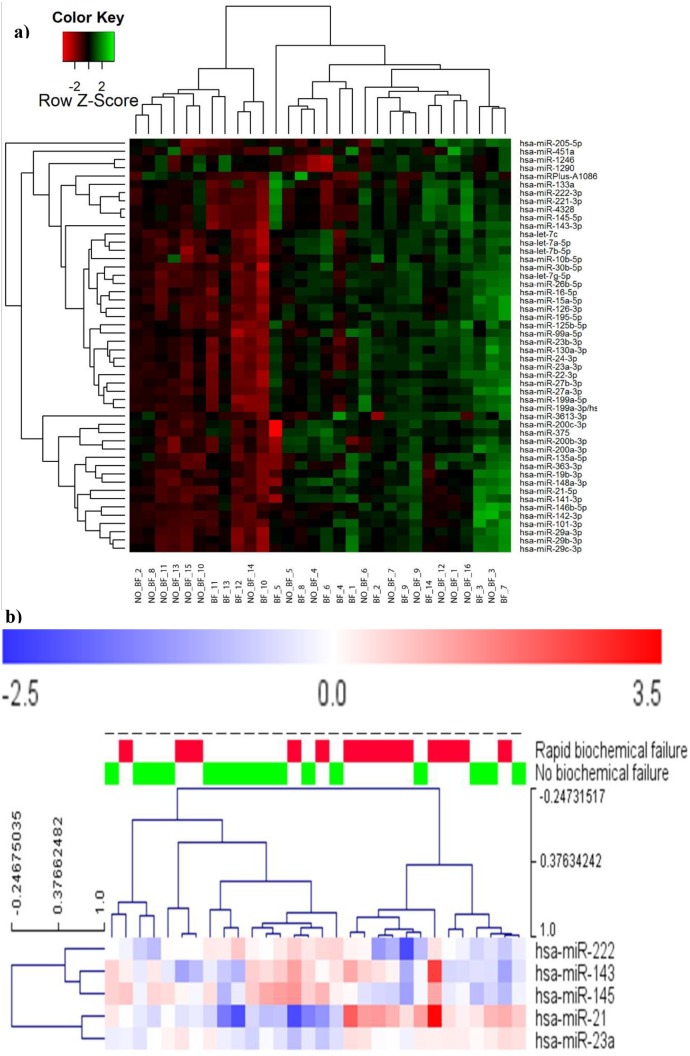
Linkage hierarchical unsupervised clustering of differentially expressed miRNAs.a) Relative expression levels of 50 miRNAs that were expressed in all 30 matched tissue samples with Gleason score 7. The X-axis shows individuals and the Y-axis shows miRNAs. Red squares encode for up-regulated miRNAs and green squares encode for down-regulated miRNAs. b) Heat Map results of the two-way hierarchical clustering based on the qPCR results. The miRNAs showed the same trend in qPCR validation and in the microarray analysis. The normalized (dCp) values have been used for the analysis. Red color represents an expression level above mean, blue color represents expression lower than the mean.